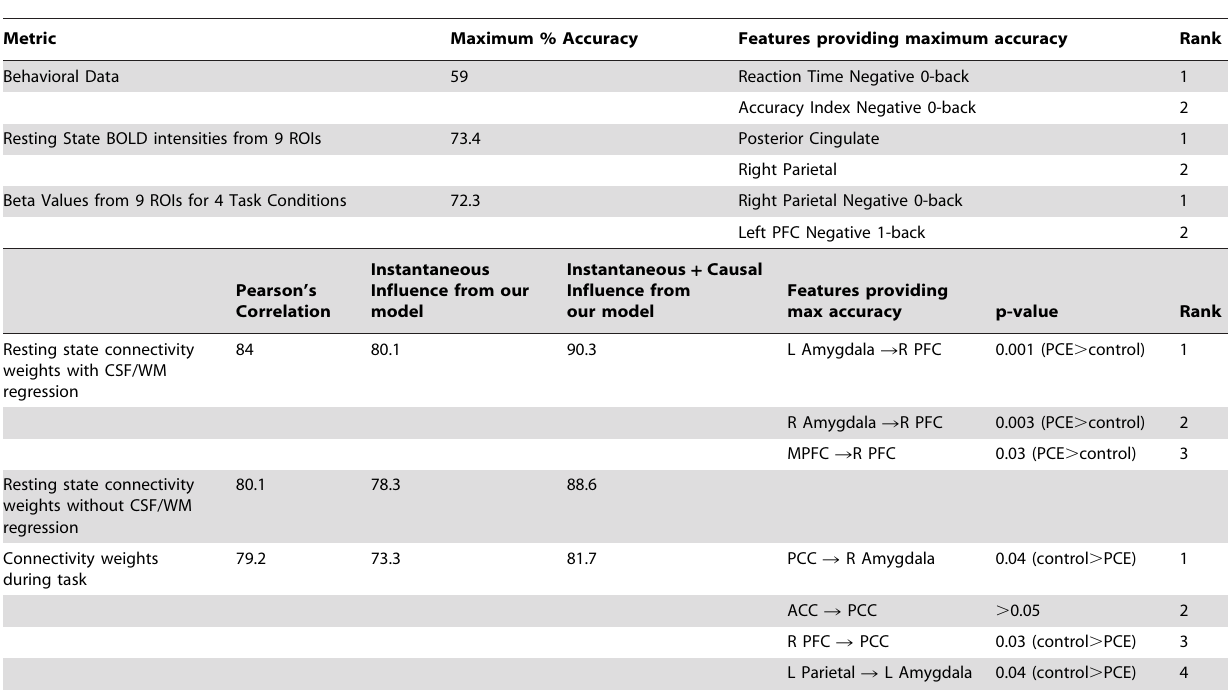
Table 2. Maximum accuracy and important features for different